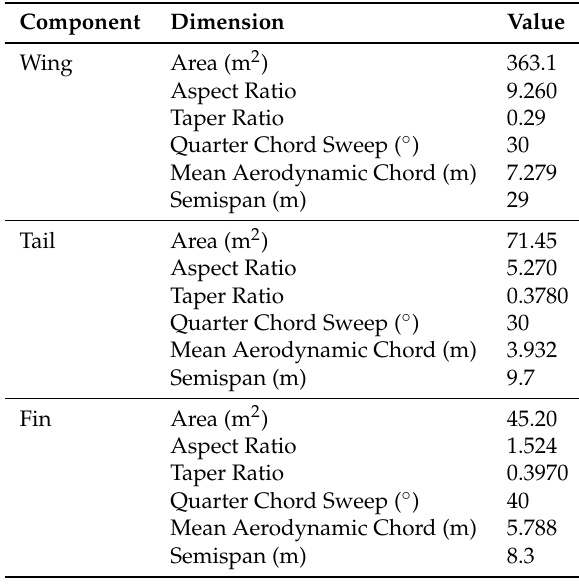
Table A2. AX-1 wing, tail and fin geometric properties [16].